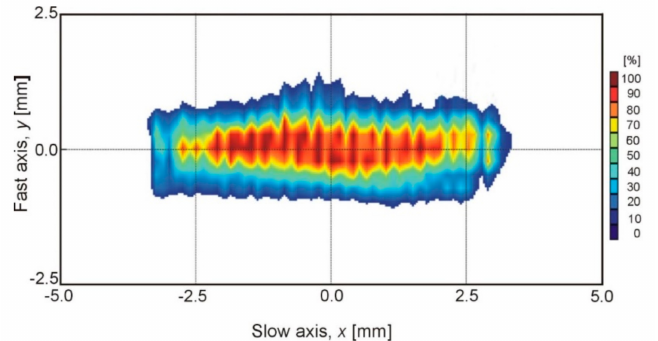
Figure 20. The 2D beam profile of the used HPDL laser in the focal plane [43]. (Reprinted with permission, copyright 2017, EBSCO